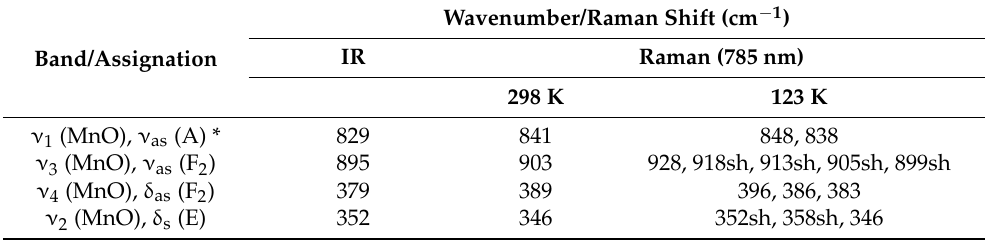
Figure 6. Raman spectra of compound 3-Mn at 298 (red) and 123 K (black) in the range of 1000–200 cm − 1 . Table 3. Assignments of permanganate ion vibrational modes in the IR and Raman spectra of compound 3-Mn